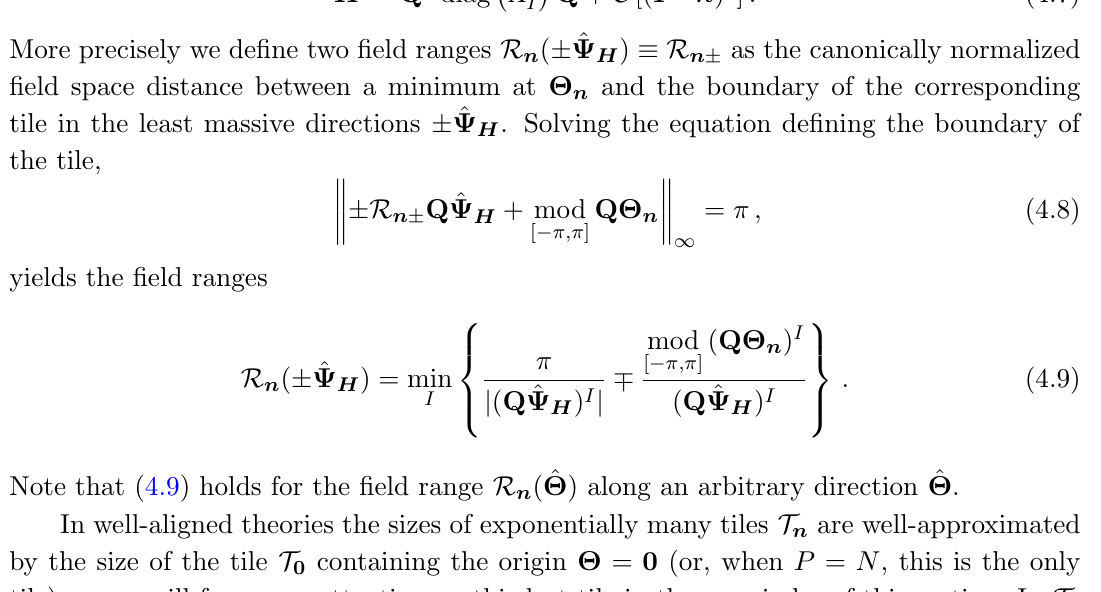
of the potential shown in (cid:12)gure 3 in canonical (cid:12)elds (cid:2) . T (30) > along the two lightest directions in the vicinity of the R (cid:6) of the D